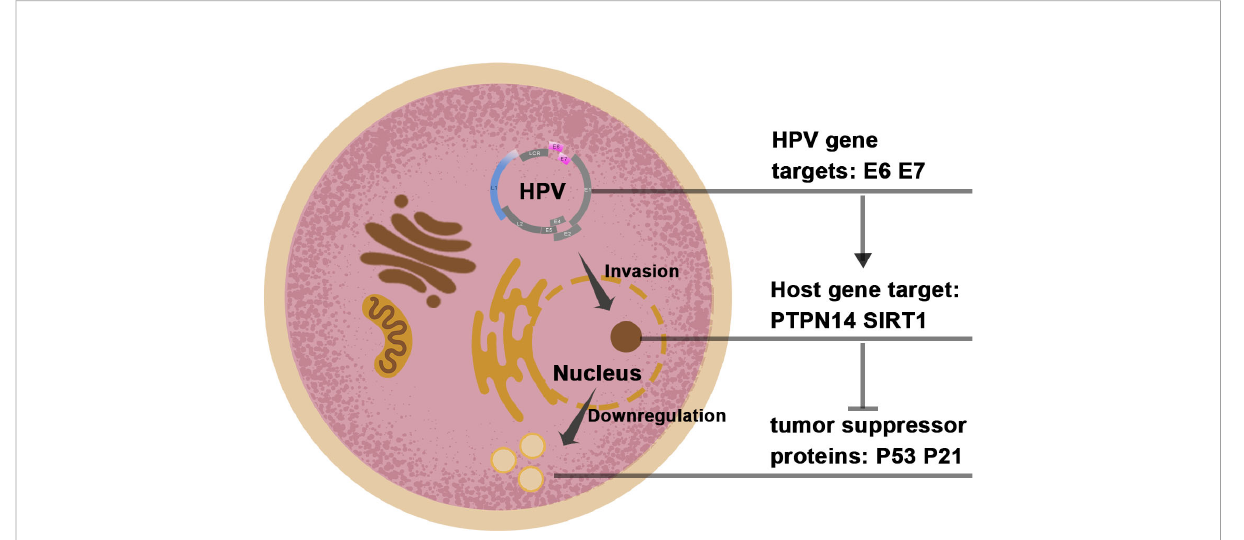
FIGURE 2 The target genomes in the HPV and host